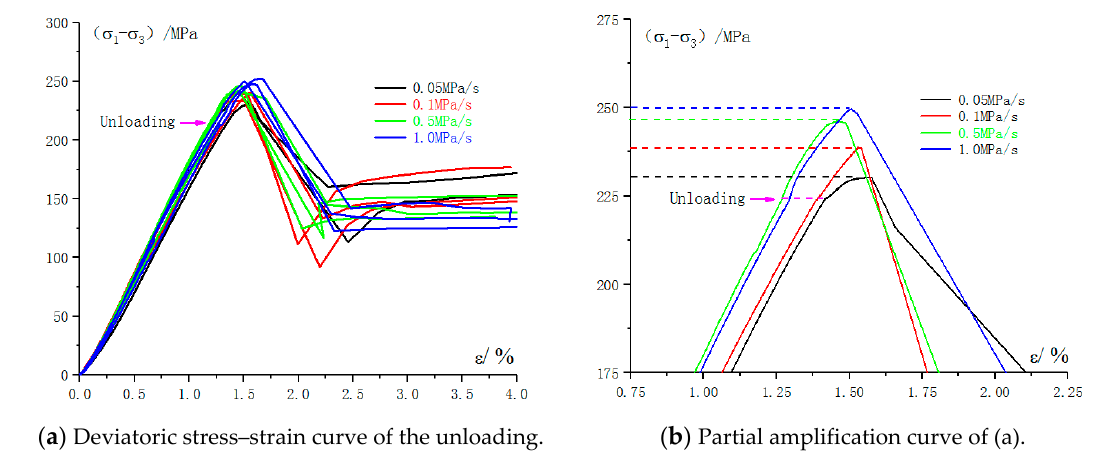
Figure 7. Triaxial unloading curve.